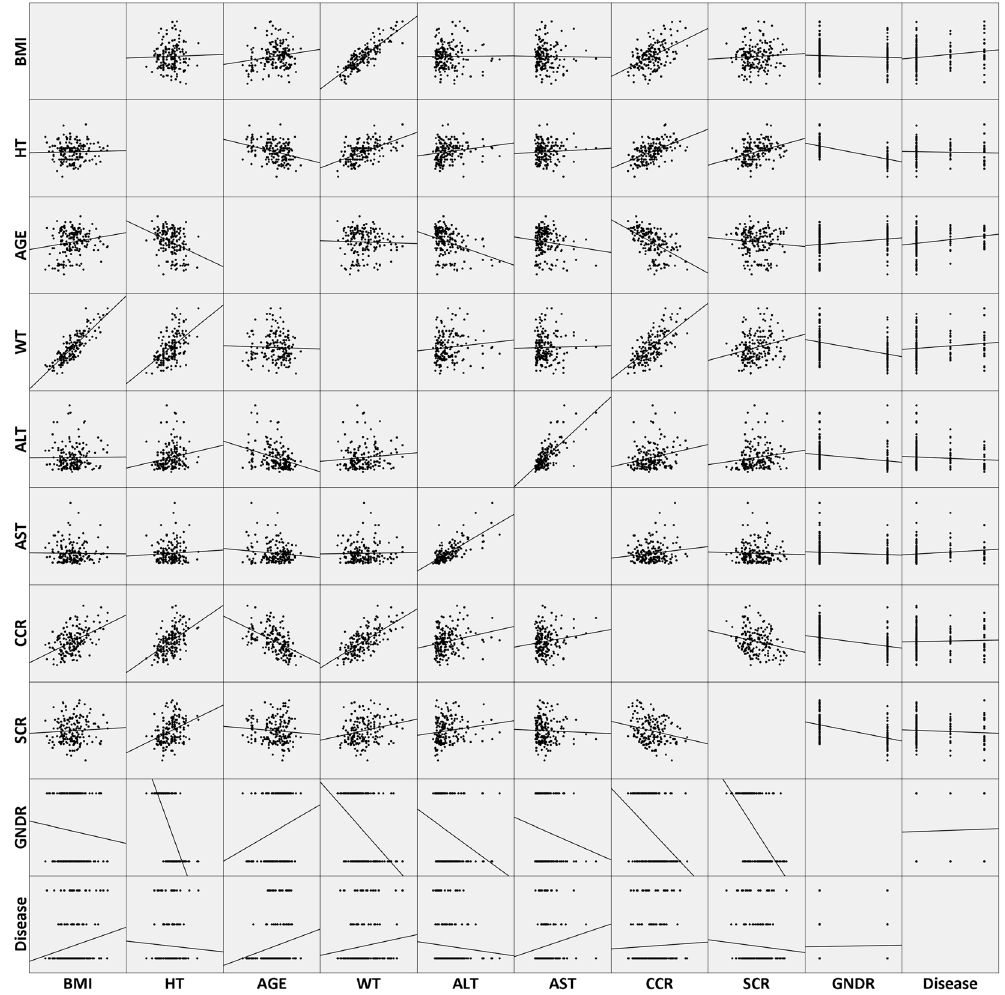
Figure 1. Relationship of all the candidate covariates. BMI: body mass index (kg/m 2 ), HT: height (cm), AGE: age (year), WT: body weight (kg), ALT: alanine transaminase (U/L), AST: aspartate transaminase (U/L), CCR: creatinine clearance (mL/min), SCR: serum creatinine ( μ mol/L), GNDR: gender (male = 1; female = 2),